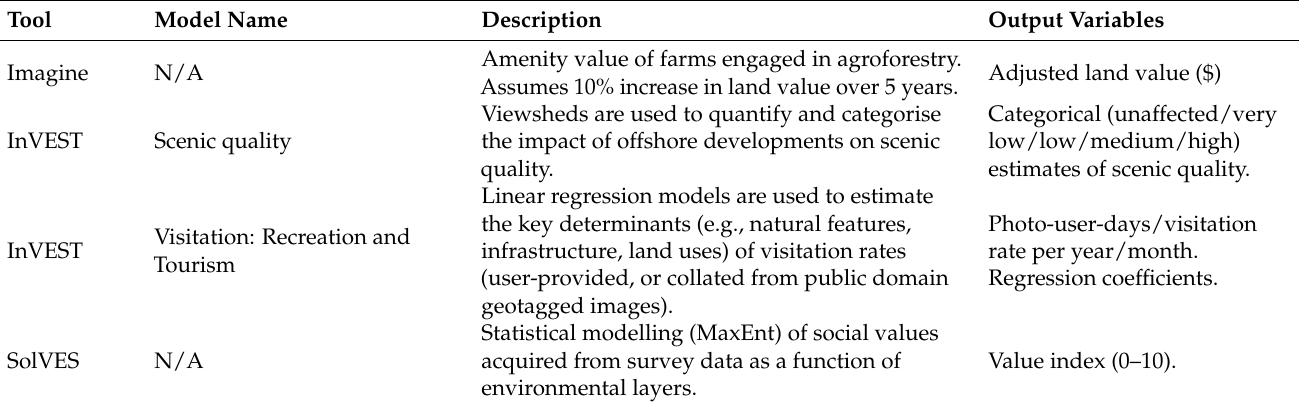
Table 9. Summary of the shortlisted tools and associated models that quantify amenity and